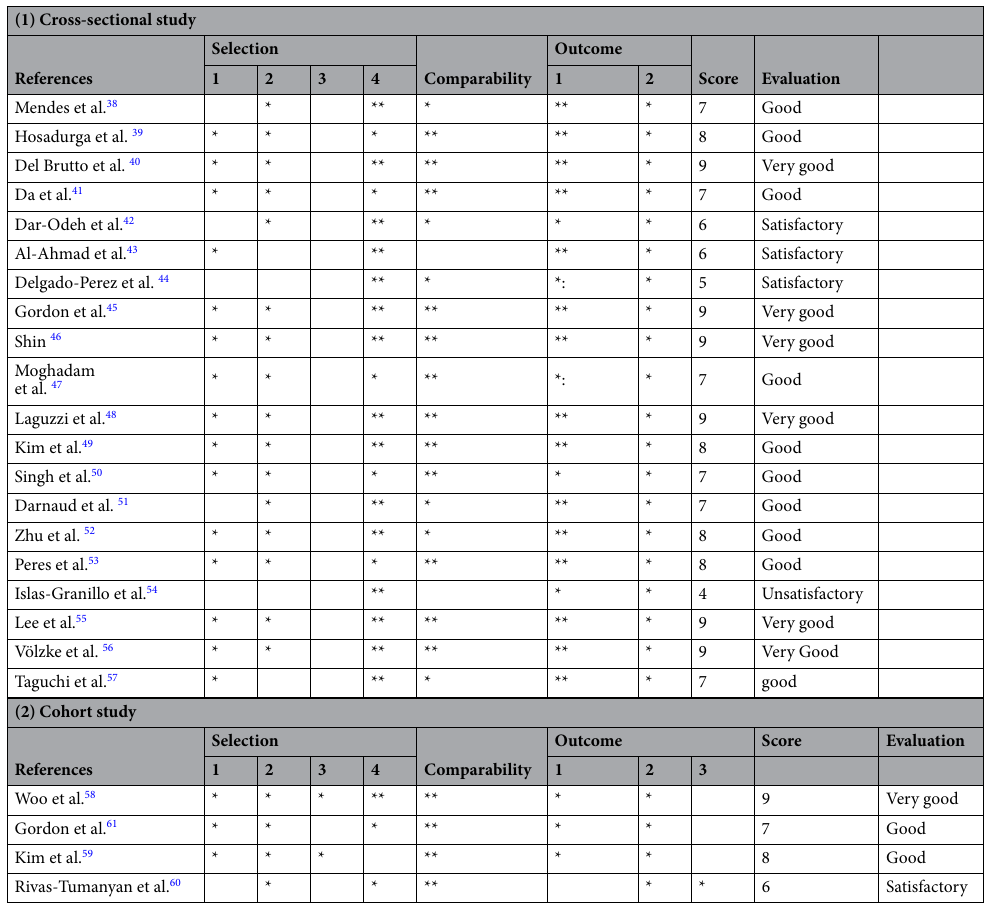
Table 2. Newcastle–Ottawa Scale score of included studies.